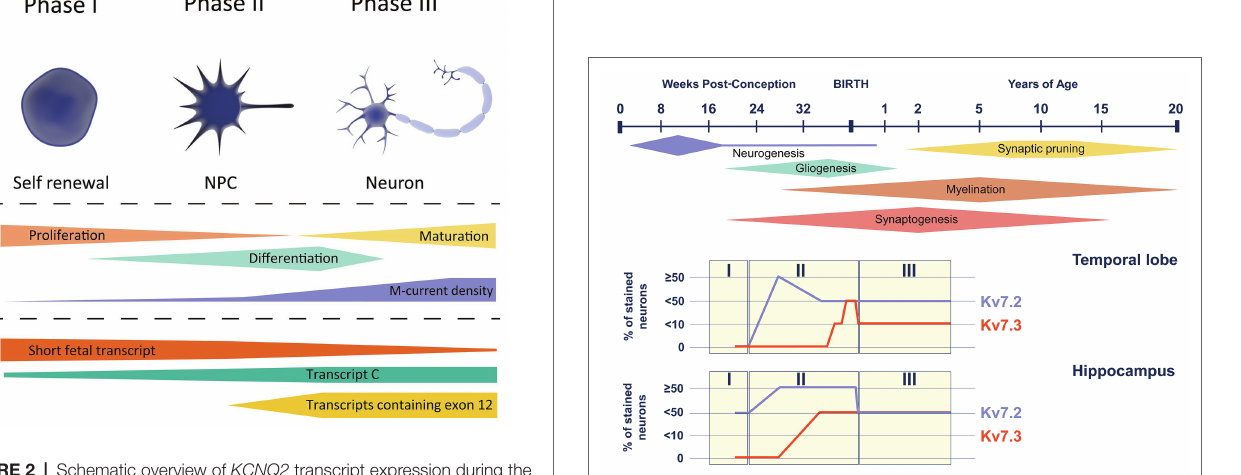
FIGURE 2 | Schematic overview of KCNQ2 transcript expression during the different phases of neuronal development. Top, showing the different cell types during differentiation; stem cell (left), neuronal progenitor cell (NPC, middle), and neuron (right). Middle, showing the cell characteristics during neuronal development, and its correlation with the M-current density. Bottom, expression profile of the different KCNQ2 transcripts based on the data exported from the LIBD stem cell browser.